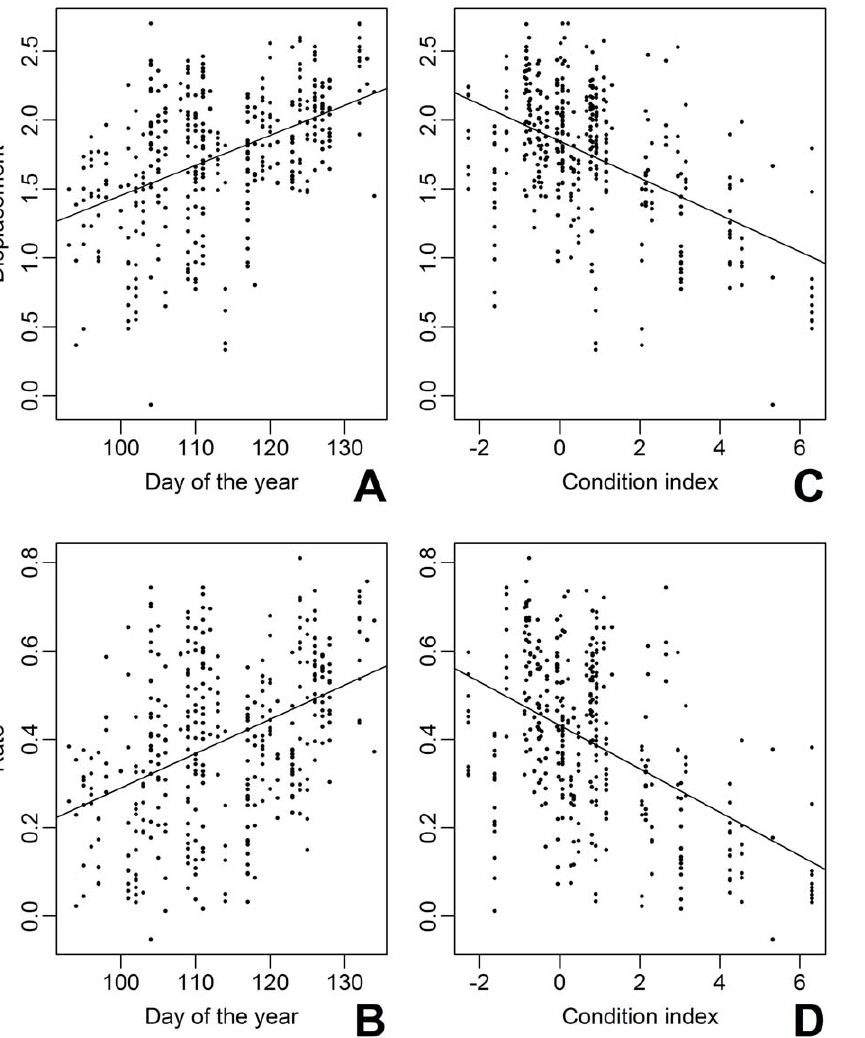
Figure 4. Model fitted movement rate and displacement distance of migratory red-eyed vireos in relation to time of spring and energetic condition. Fitted values were extracted from a mixed model with seven fixed effects and the individual bird as a random component on the log transformed linear displacement distance (m, A and C) and movement rate (m min -1 , B and D) during two hour increments throughout the first three days of stopover. Migrants were released and tracked from early to late spring (4 April to 13 May, 2007 and 2008) in a range of energetic conditions (index is relative to lean body mass [0, see text].